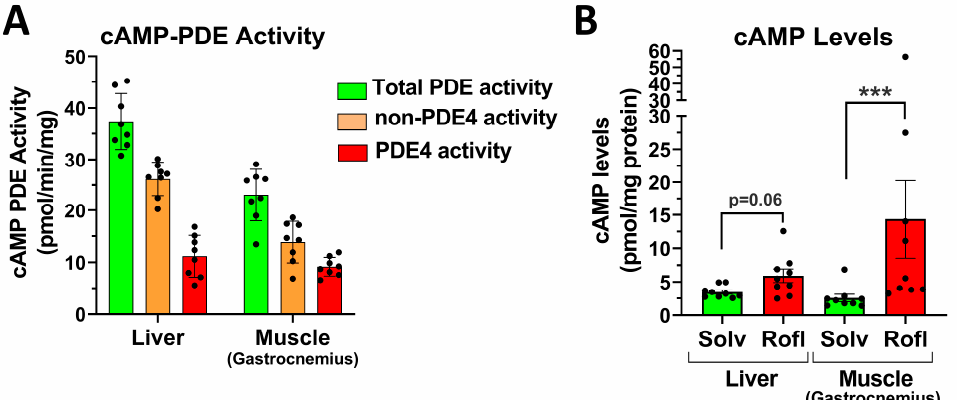
Figure 6. PDE4 activity and cAMP levels in metabolic tissues. ( A ) Detergent extracts, prepared from mouse liver and skeletal muscle (gastrocnemius), were subjected to in vitro cAMP-PDE activity assays in the presence or absence of the PDE4 inhibitor rolipram (10 µM). Total cAMP-PDE activity is defined as the rate of cAMP hydrolysis measured in the absence of rolipram, whereas PDE4 and non-PDE4 activity are defined as the fraction of total activity that is either inhibited or that is insensitive to inhibition by rolipram, respectively. ( B ) Shown are cAMP levels in the tissues of postprandial mice at 30 min after treatment with the PAN-PDE4 inhibitor roflumilast (5 mg/kg; i.p.) or solvent control (Solv). Data represent the mean ± SEM. Statistical significance was determined using the Mann-Whitney test and is indicated as *** ( p < 0.001).